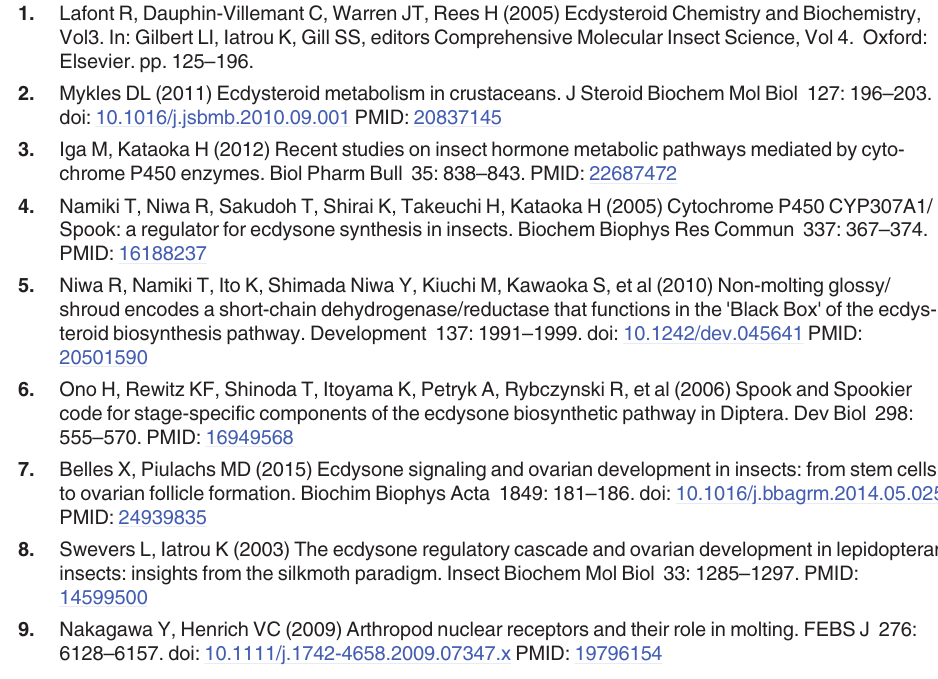
S1 Fig. Nucleotide sequences of OmSpo . Underlines indicate the region determined by RNA- seq. (TIF) S2 Fig. Nucleotide sequences of OmShd . Underlines indicate the region determined by RNA- seq. (TIF) S3 Fig. Effects of dsRNA injection. Relative expression levels of OmSpo in ovaries (A) and OmShd in midguts (B) after dsRNA injection. Abnormal exuvia after dsShd injection (C). (TIF) S4 Fig. Ecdysteroids in the hemolymph of nymphs injected with dsRNA. Chromatograms of ecdysone and 20E in the hemolymph of nymphs determined by LC-MS/MS (A). Red line indi- cates 20E, while blue line indicates ecdysone. Intensity was indicated as counts per second (cps). MS/MS spectra of ecdysone and 20E detected in the hemolymph of nymphs injected with dsShd or standards (B). The amounts of ecdysone and 20E in the hemolymph of control or nymphs injected with dsShd determined using LC-MS/MS (C). u.d. indicates below detection limit.